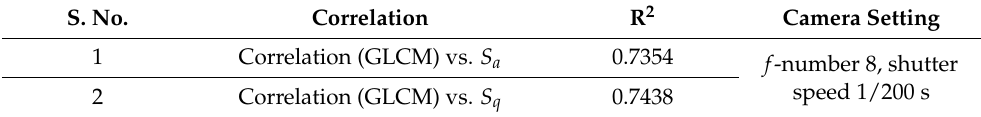
S. No. Correlation R 2